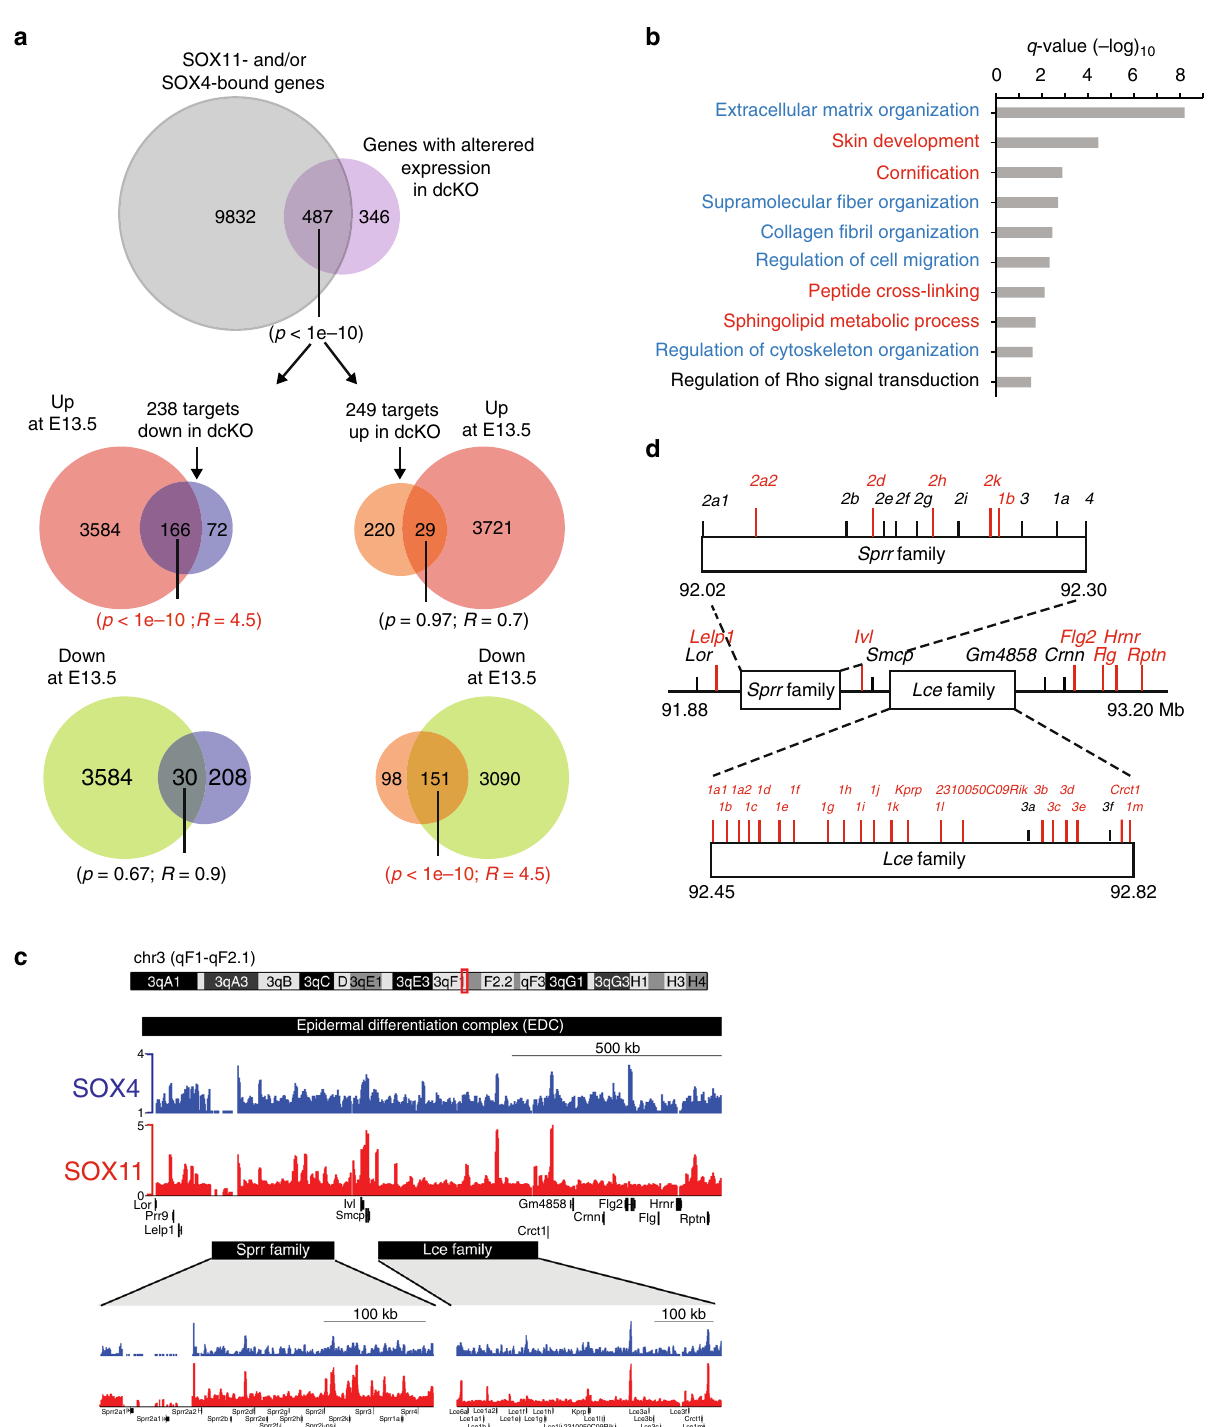
Fig. 7 Identi fi cation of direct targets of SOX11 and SOX4 in embryonic epidermis. a Top Venn diagram shows the overlap of SOX4/11-bound targets